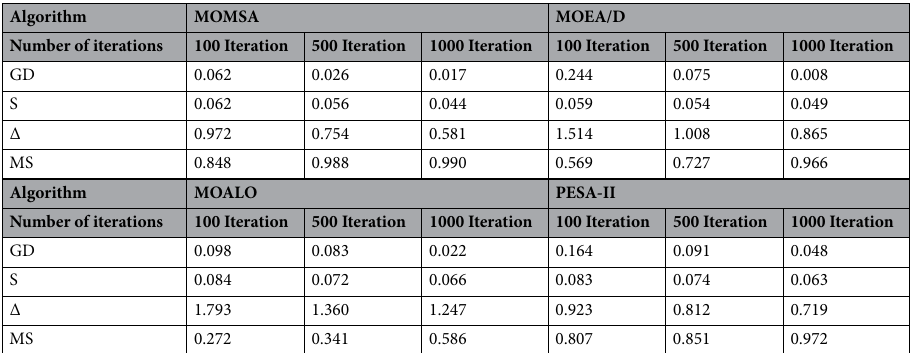
Table 3. Statistical results for Sensitivity analysis on the number of iterations in the ZDT1 multi-objective test